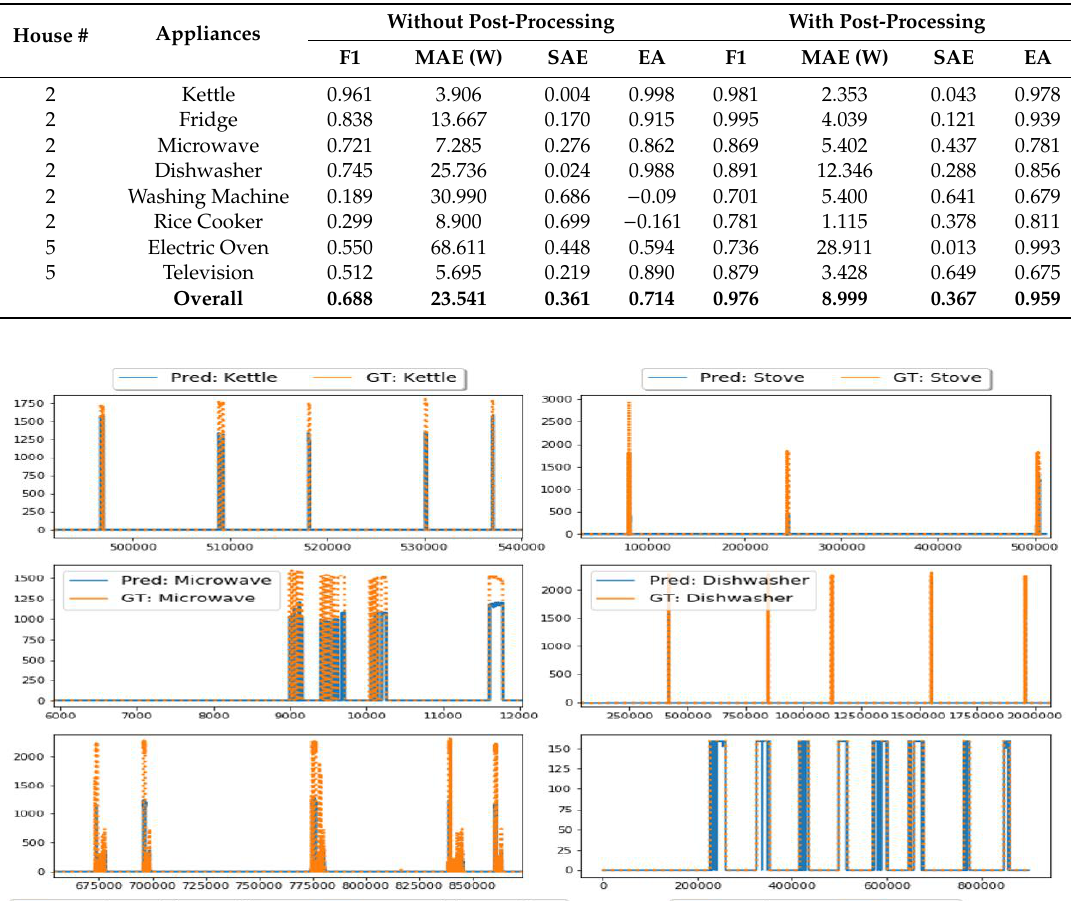
Table 3. Performance evaluation of the proposed algorithm in a seen scenario based on the ECO datasets.